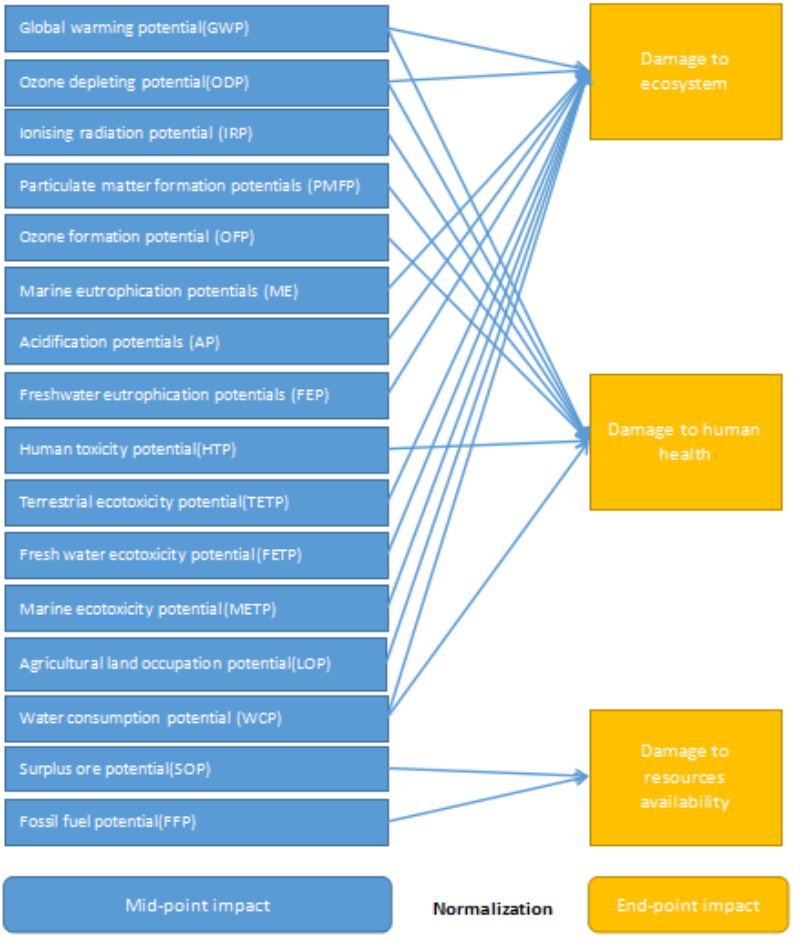
Figure 2. LCA-ReCiPe 2016 life cycle impact assessment process (Huijbregts, Steinmann et al., 2017)